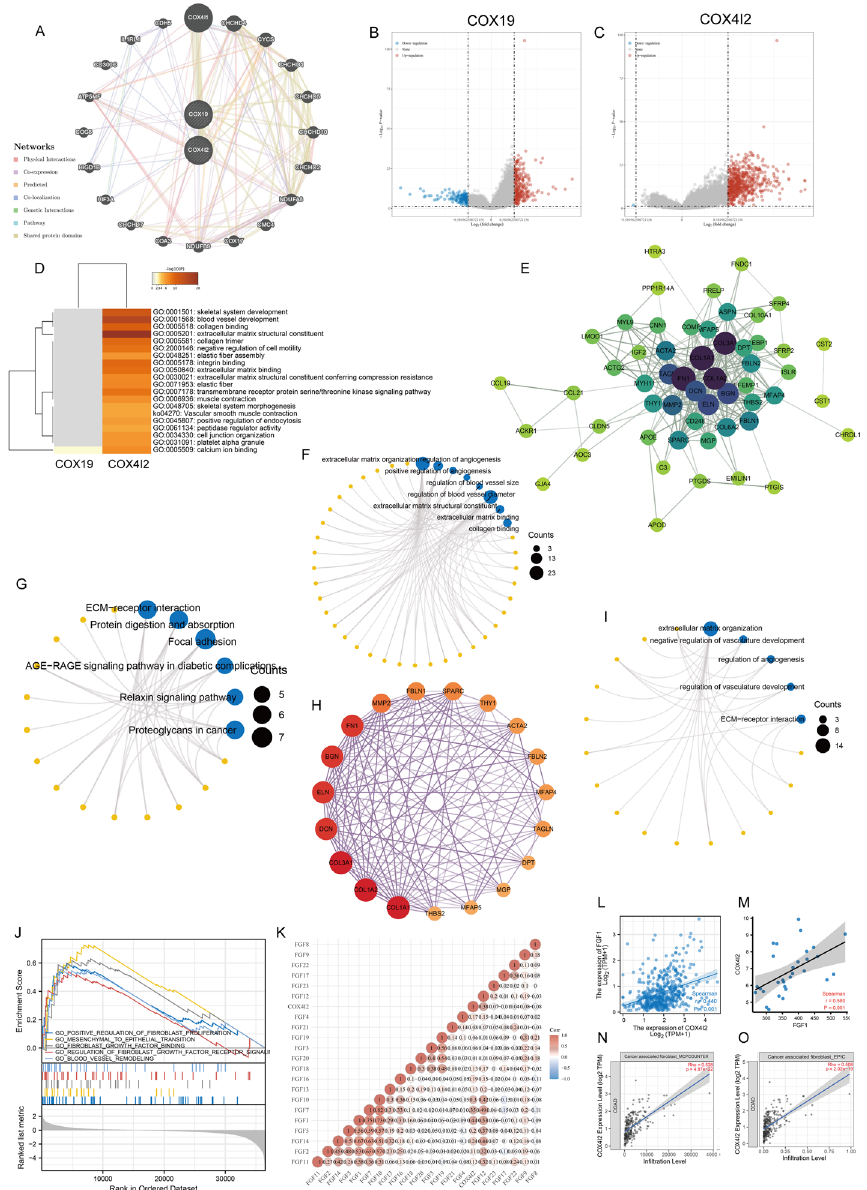
Fig. 3 PPI network and enrichment analysis. a PPI constructed by GeneMANIA; COX19 and COX4I2 are at the core of this network. b , c Volcano map of differentially expressed genes after altered COX19 ( b ) and COX4I2 ( c ) levels. Red indicates upregulation, blue indicates downregulation. Data on the abscissa are differences in gene expression (log2 fold change); data on the ordinate represent the significance of these differences ( log10 P adj). d GO and KEGG enrichment analysis of COX19 and COX4I2 . Each row represents 1 cluster; − colors indicate significance, and gray color indicates non‑significance. Heatmap showing the top 20 clusters correlated with COX19 and COX4I2 . e Network of COX4I2 and genes significantly correlated with its expression. Darker colors and larger sizes indicate higher degrees of correlation. f The significantly enriched terms in GO analysis. g The significantly enriched terms in KEGG analysis. h The hub module with the highest scores analyzed by MCODE. i GO enrichment analysis of the module. j GSEA of COX4I2 . k Correlation coefficient matrix of COX4I2 and proteins of the FGF gene family. l Correlation between COX4I2 and FGF1 expression. m Analysis of the correlation between the serum COX4I2 and serum FGF1 in the patients ( n the comparison between the two groups. n , o Correlation of COX4I2 levels with CAFs, from TIMER using the algorithms MCPCOUNTER ( n ) and EPIC ( o ). MCODE Molecular Complex Detection; for other Abbreviations,